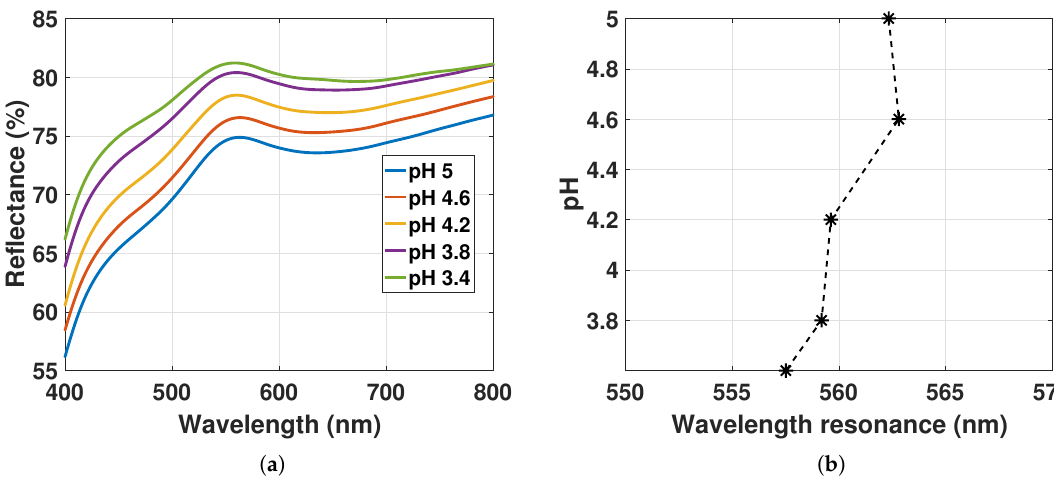
Figure 10. ( a ) Reflectance spectra of GNP-hydrogel with ND 01 at 8.86 × 10 9 particles/mL fitted with a smoothing spline function for pH 5 to 3.4; ( b ) LSPR peak position from Figure 10a as a function of hydrogel deswelling stimulated with pH solutions from 5 to